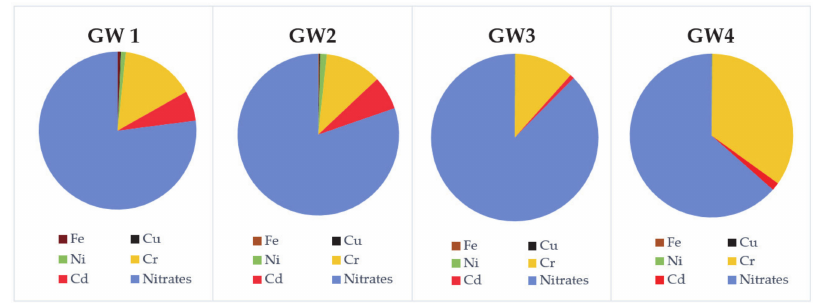
Figure 9. Contribution of Fe, Cu, Ni, Cr, Cd, and nitrates to the mean values of